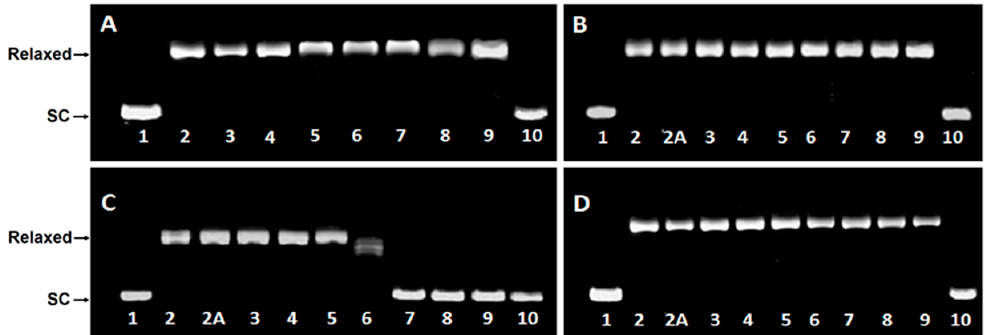
Figure 3. Influence of compounds 1a ( A ), 1b ( B ), 2a ( C ) and 2b ( D ) on conversion of relaxed plasmid DNA to supercoiled molecule. Control reactions were carried out in the absence of Topo I (supercoiled plasmid, SC) (lane 1), with Topo I (relaxed plasmid) (lane 2), with Topo I and 0.1% DMSO (lane 2A). Plasmid conformation was analyzed in increasing concentrations of investigated compounds (lane 3–9, concentration: 0.5; 1; 5; 10; 15; 20 and 30 µM, respectively) with constant Topo I concentration. 9AA